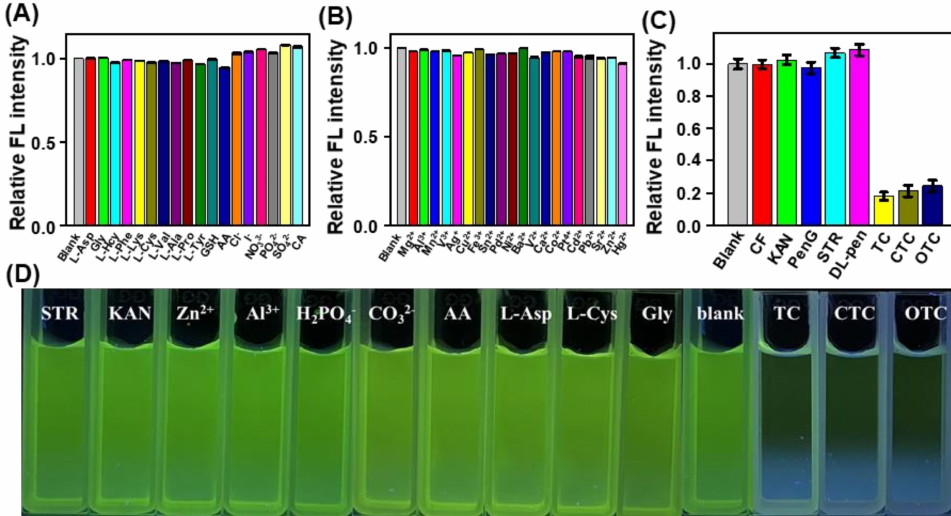
Figure 5. Influences of various interferences, such as ( A ) L − Asp, Gly, L − Hcy, L − Phe, L − Lys, L − Cys, L − Val, L − Ala, L − Pro, L − Tyr, GSH, AA, CA, Cl − , I − , NO 3 − , PO 43 − , and SO 42 − (25.0 µ M for each); ( B ) Mg 2+ , Al 3+ , Mn 2+ , V 3+ , Ag + , Cu 2+ , Fe 3+ , Sn 2+ , Pd 2+ , Ni 2+ , Ba 2+ , V 2+ , Ca 2+ , Co 2+ , Pt 4+ , Cd 2+ , Pb 2+ , Sr 2+ , Zn 2+ , and Hg 2+ (25.0 µ M for each); and similar species, such as ( C ) CF, KAN, PenG, STR, and DL − PEN (25.0 µ M for each) on the relative fluorescence intensity of the biomass − based C − dots at 520 nm. ( D ) Fluorescence images of the biomass − based C − dots following incubation with the indicated substances (50.0 µ M for each) under a 365 UV lamp. The concentration of the biomass-based C − dots was 25.0 µ g/mL for TC and CTC and 10.0 µ g/mL for